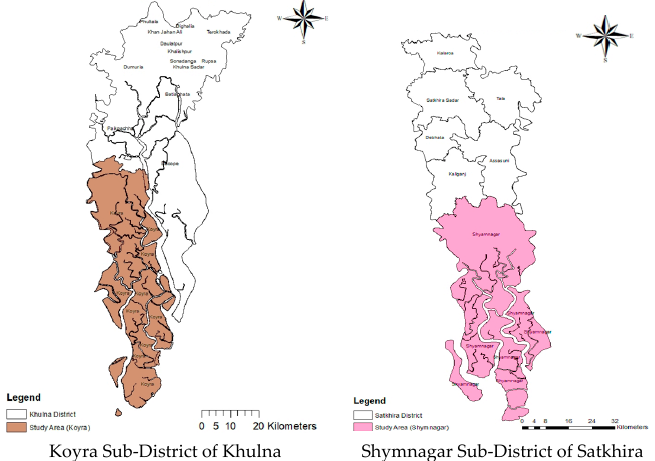
Figure 2. Map of the study